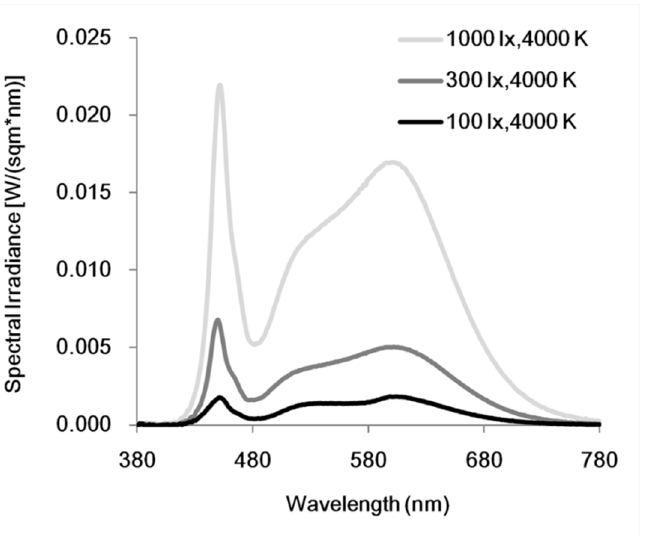
Figure 1. The layout of the laboratory. Note that only one participant was scheduled at a time.